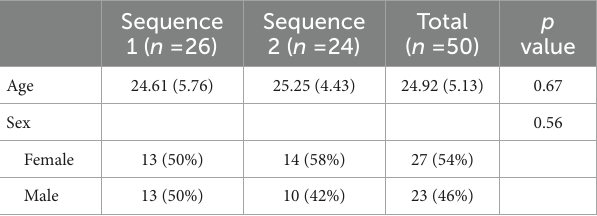
TABLE 2 Demographics characteristics of Brazilian participants according to the sequence of testing (sequence 1 = face-to-face 1st; sequence 2 = online